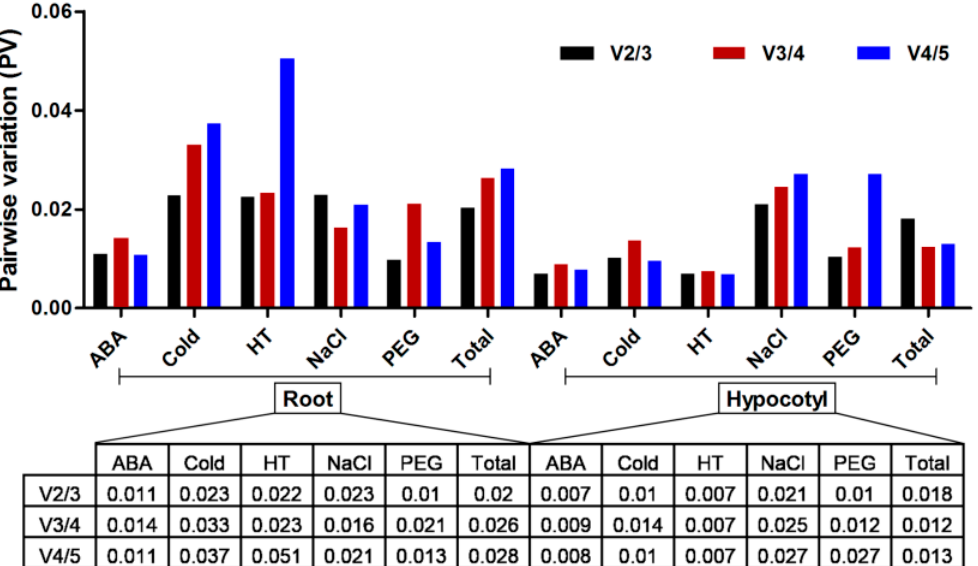
Figure 5. Pairwise variation (PV) to identify the optimal number of HKGs for precise normalization. The PV (V n /V n+1 ) was analyzed between the NFs (Normalization Factors) NF n and NF n+1 using geNorm program. Abbreviations: HT: High Temperature treatment; Cold: Cold treatment; ABA: Abscisic Acid treatment; NaCl: Sodium Chloride treatment; PEG: Polyethylene Glycol treatment.